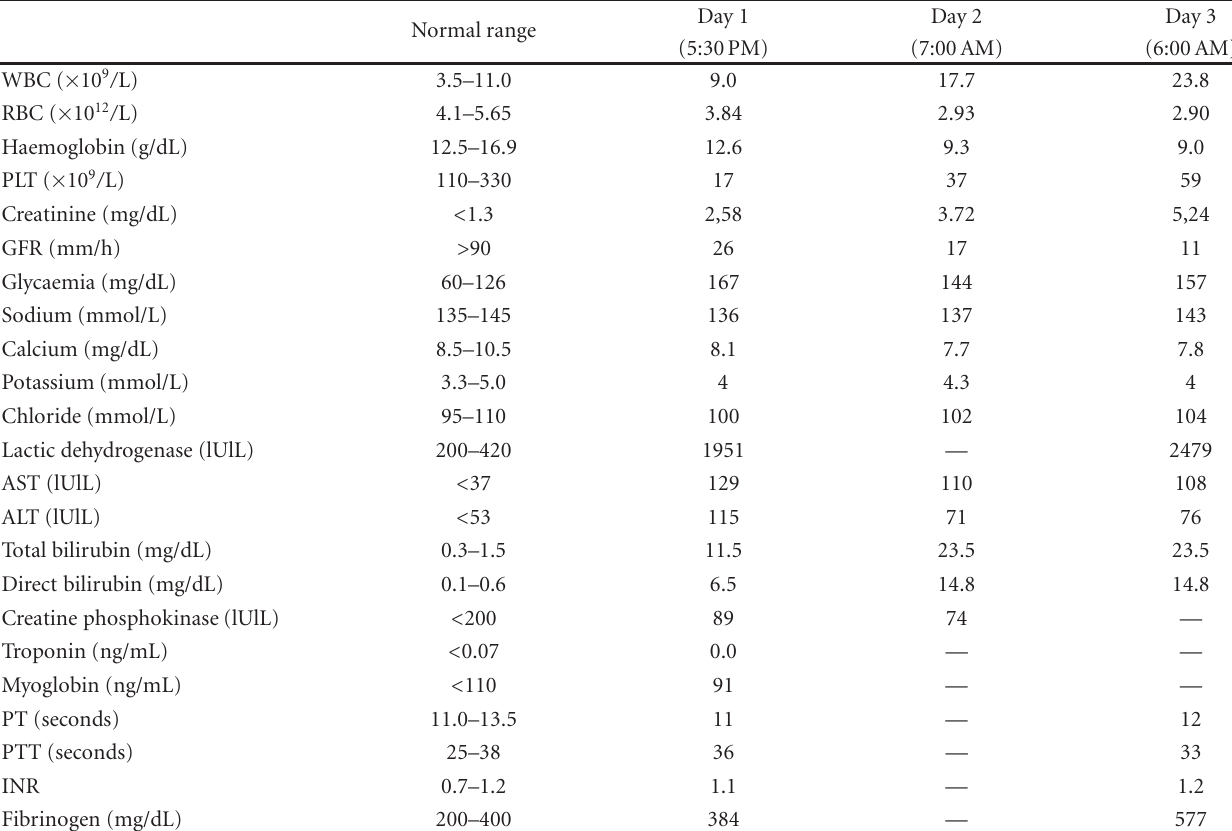
Table 1: Patient biochemical parameters detected during hospital stay. Normal